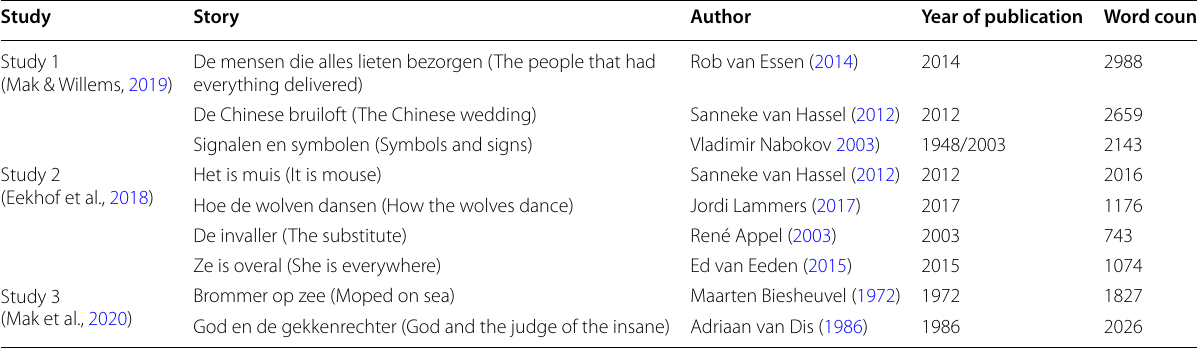
Table 2 Descriptive information for the stimulus stories used in the three previous studies